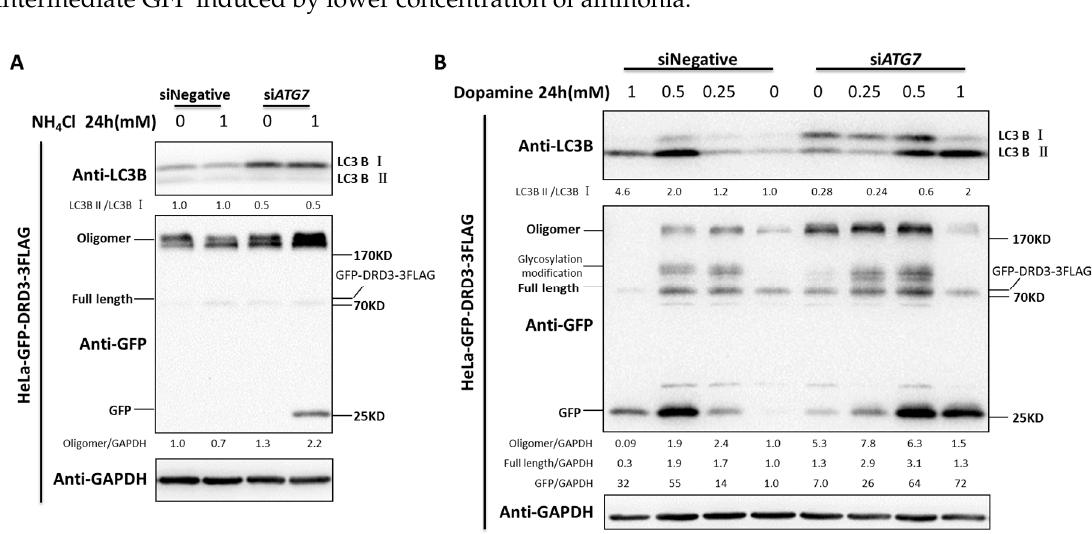
Figure 6. Autophagy inhibition decreases dopamine receptor degradation and increases oligomer formation. ( A ) ATG7 RNAi in HeLa cells stably expressing GFP-DRD3-3FLAG were treated with 1 mM ammonia for 24 h. ( B ) ATG7 RNAi in HeLa cells stably expressing GFP-DRD3-3FLAG were treated with different concentrations of dopamine for 24 h. Experiments were repeated at least three times and representative Western blots are shown. Densitometric analysis was performed and quantification results were labeled below the corresponding blots.